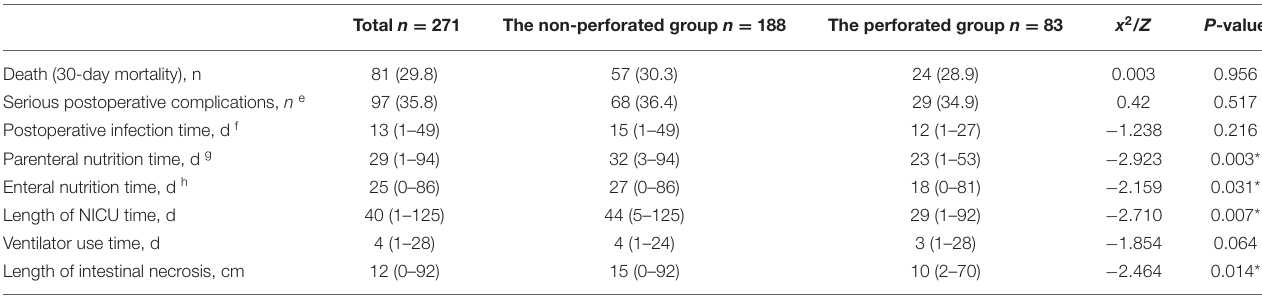
TABLE 2 | Post-operative results between two groups [n (%), M (min, max)].